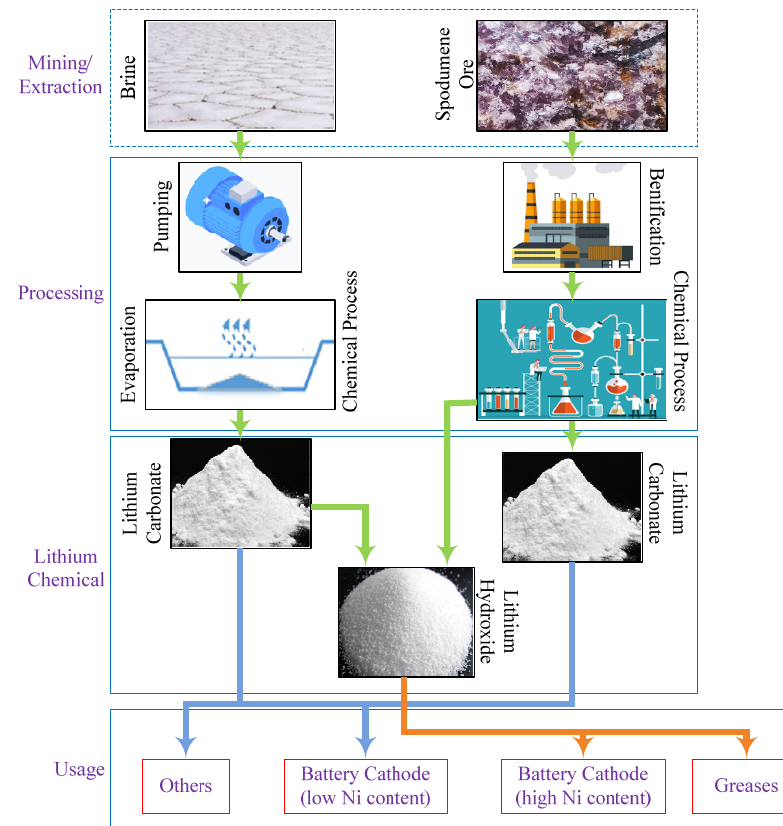
Figure 10. Lithium supply chain.